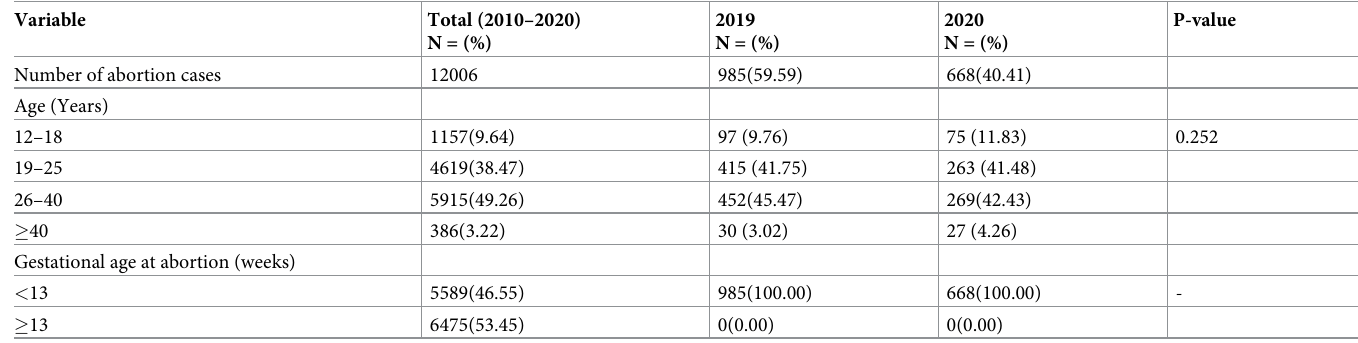
Table 2. Comparison of number of abortions, age and gestation age at termination across the pre-COVID-19 and intra-COVID-19 era.